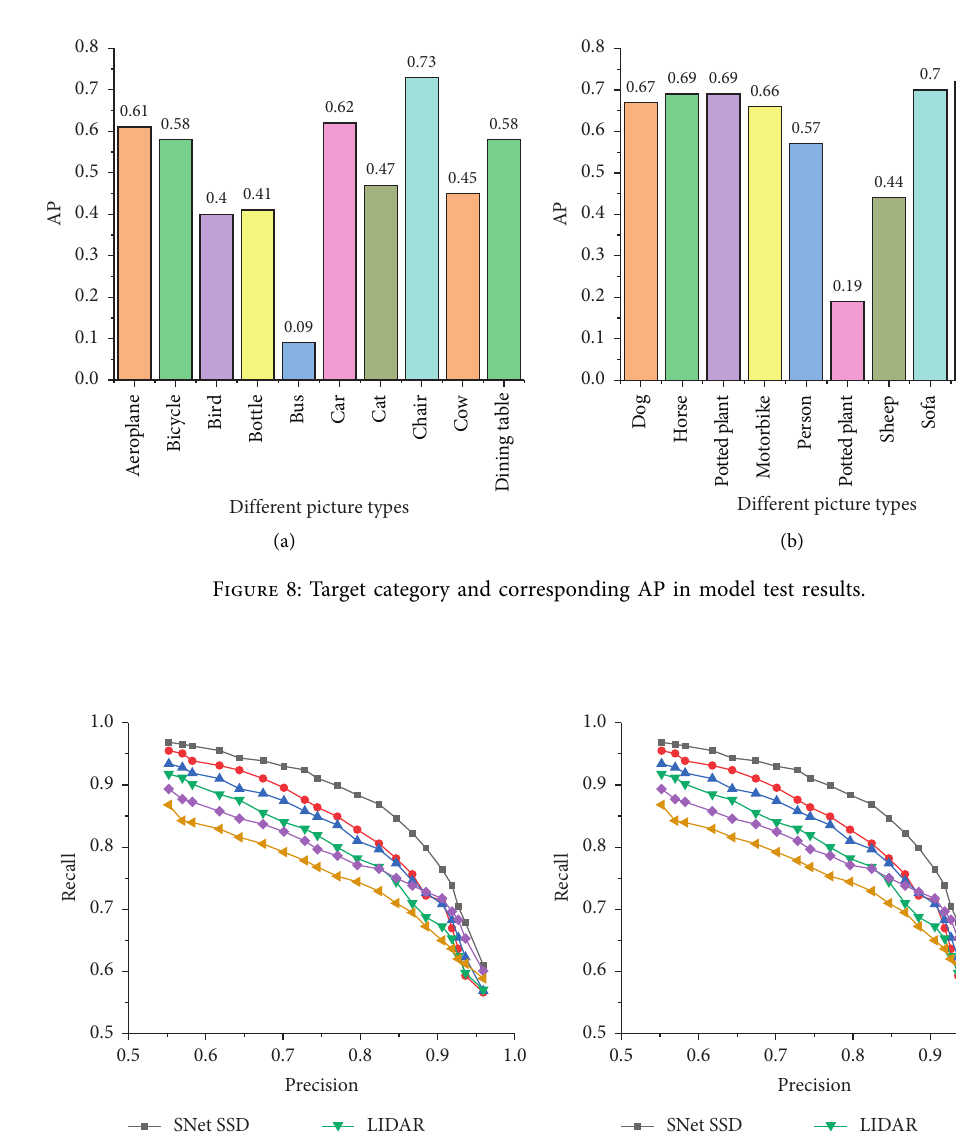
Figure 12 is the placement and virtual-real registration effect of the cylinderObject in the system in the frustum.